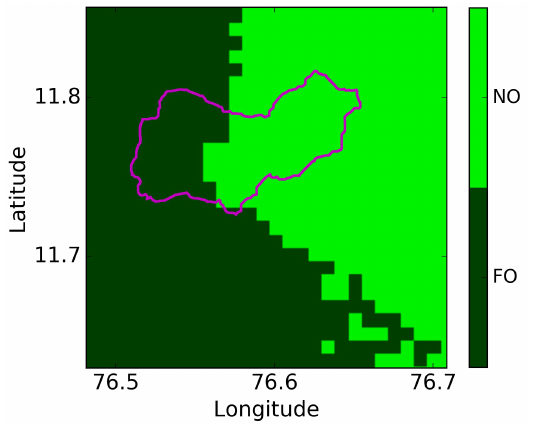
Figure 2. Land-cover map for the study area as considered in the SMOS retrieval algorithm. “NO” is the nominal surface composed of bare soil and low vegetation and FO is for the forest